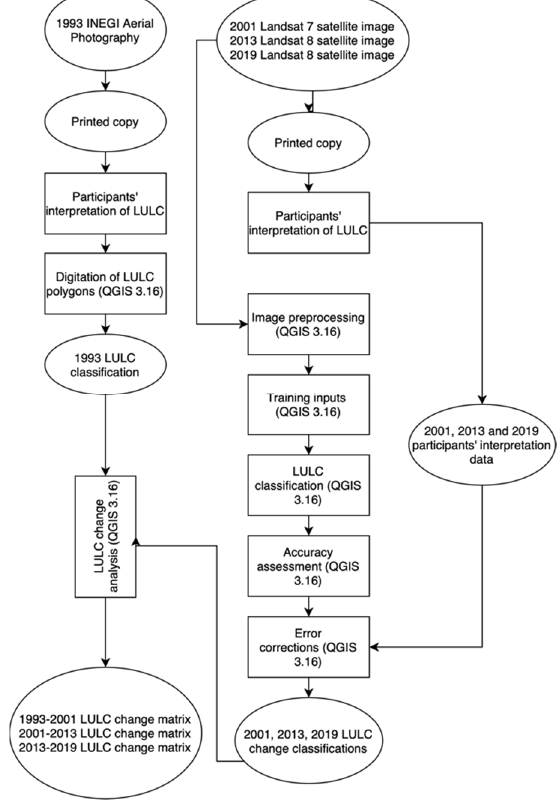
Figure 2. Workflow of LULC analysis.